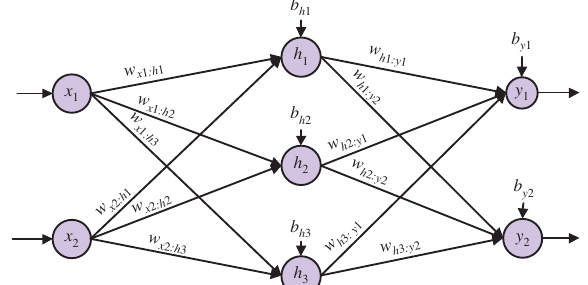
Figure 2: Feed-Forward